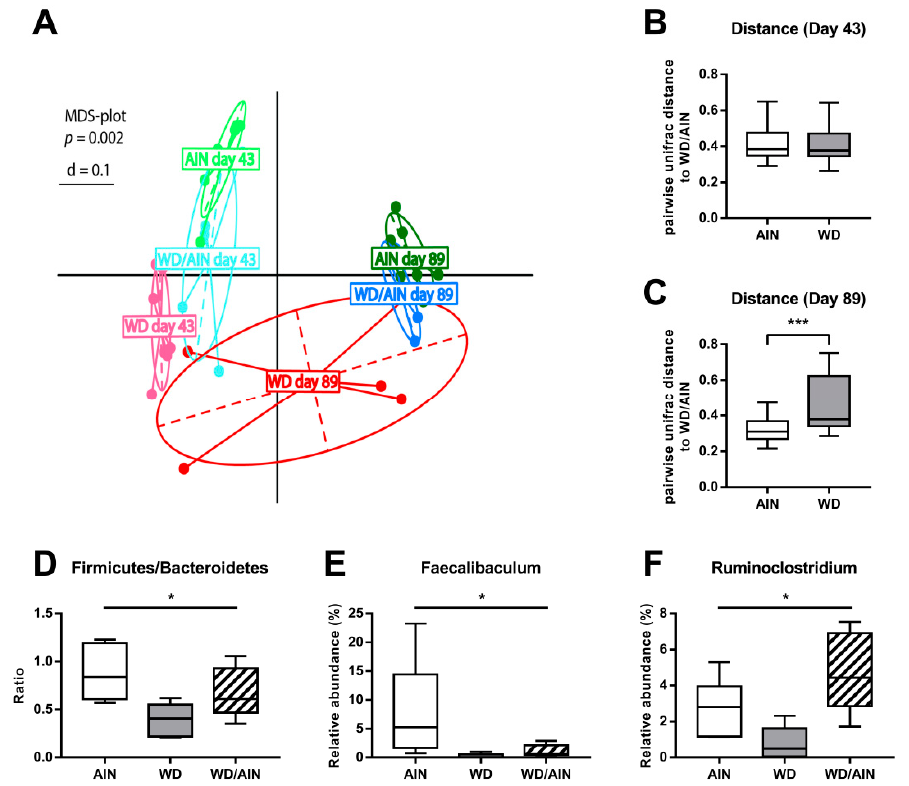
Figure 5. E ff ect of the diets on the microbiome. ( A ) Multi-dimensional scaling plot of fecal samples from day 43 (first day after diet switch) and from day 89 (47th day after diet switch), ( B , C ) pairwise UniFrac distances between the WD / AIN group and the AIN and WD groups, respectively. E ff ect of the diets on day 89 on the: ( D ) Firmicutes / Bacteroidetes ratio, ( E ) relative abundance of Faecalibaculum, and ( F ) relative abundance of Ruminoclostridium. * p < 0.05, *** p < 0.001.